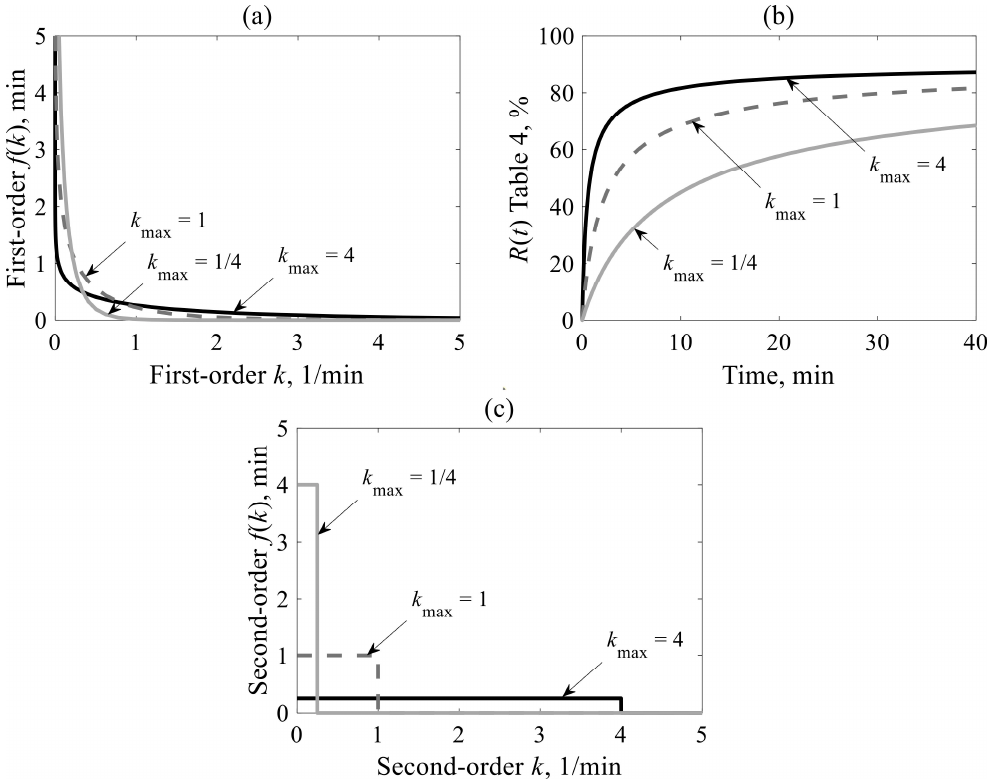
Figure 3. ( a ) Representation as first-order f ( k )s from second-order models with Rectangular f ( k )s, ( b ) Time-recovery curves, Table 4, ( c ) Second-order f ( k )s, Rectangular distributions.